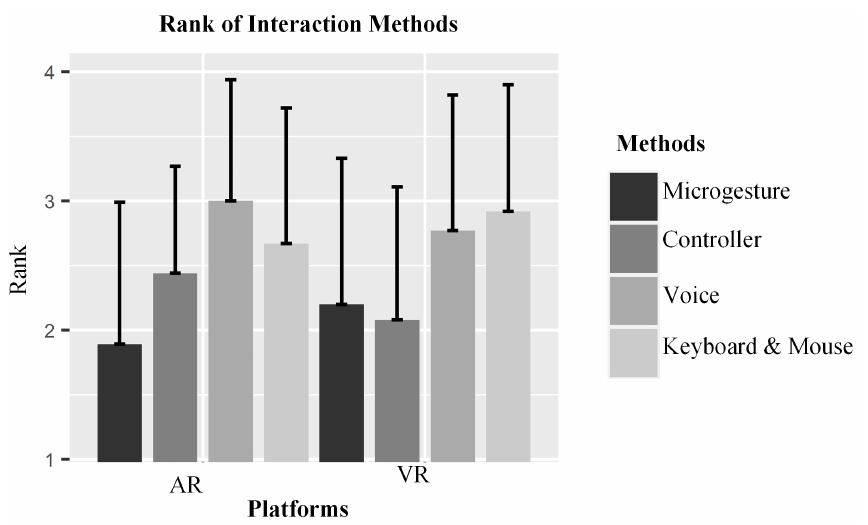
Figure 9. Ranking of four interaction methods for VR and AR systems averaged across 40 participants (1 = most preferred; 4 = least preferred). [In addition, see Table A3 in the Appendix